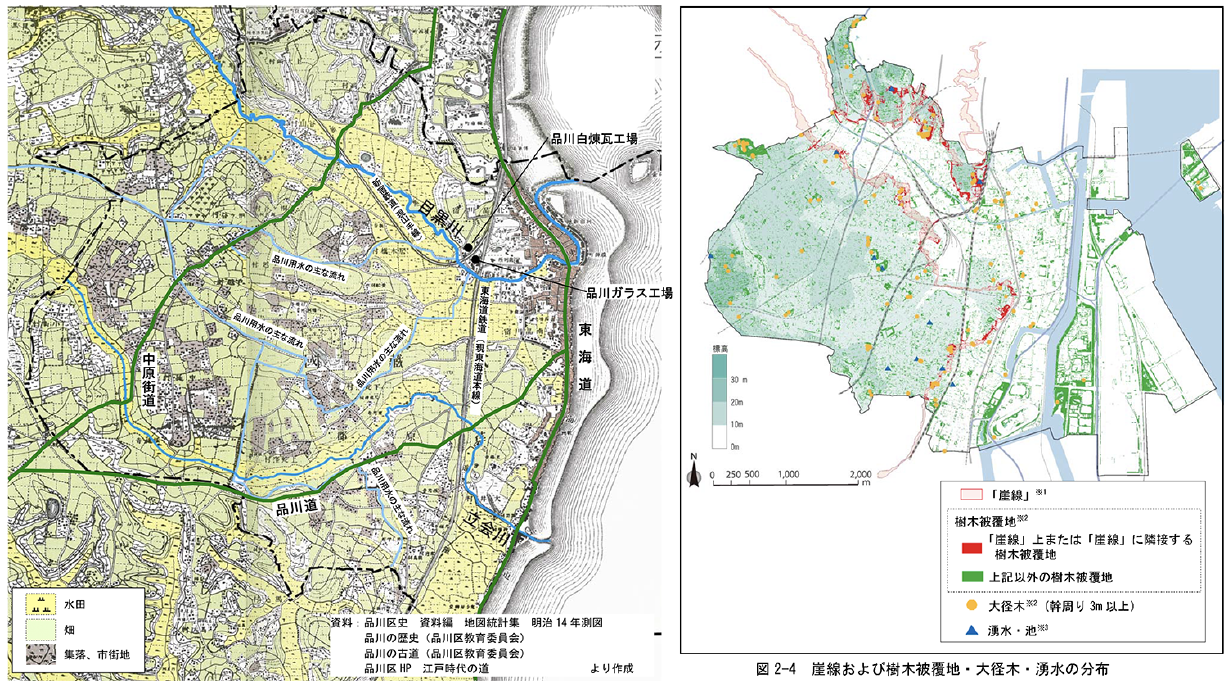
Figure 8. The Oimachi landscape in 1881 (left) and green cover in current urban environment, depicting the old ridge in red, large trees in orange and wells in blue (right). Source: Courtesy of the City of